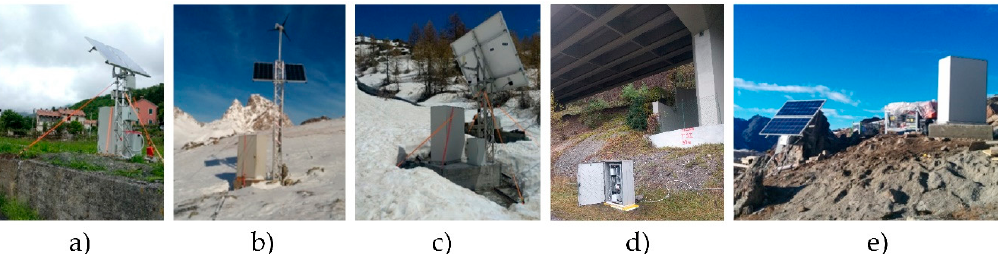
Figure 5. Principle of cycle measurements and signal analysis (automatic probe stop detection). From the start to end cycle, the probe is constantly weighted by the load cell (in the Ground Control Unit (GrCU)) that stops all the activities in case of lightening (obstacles in the tube, excessive deformations, etc.).